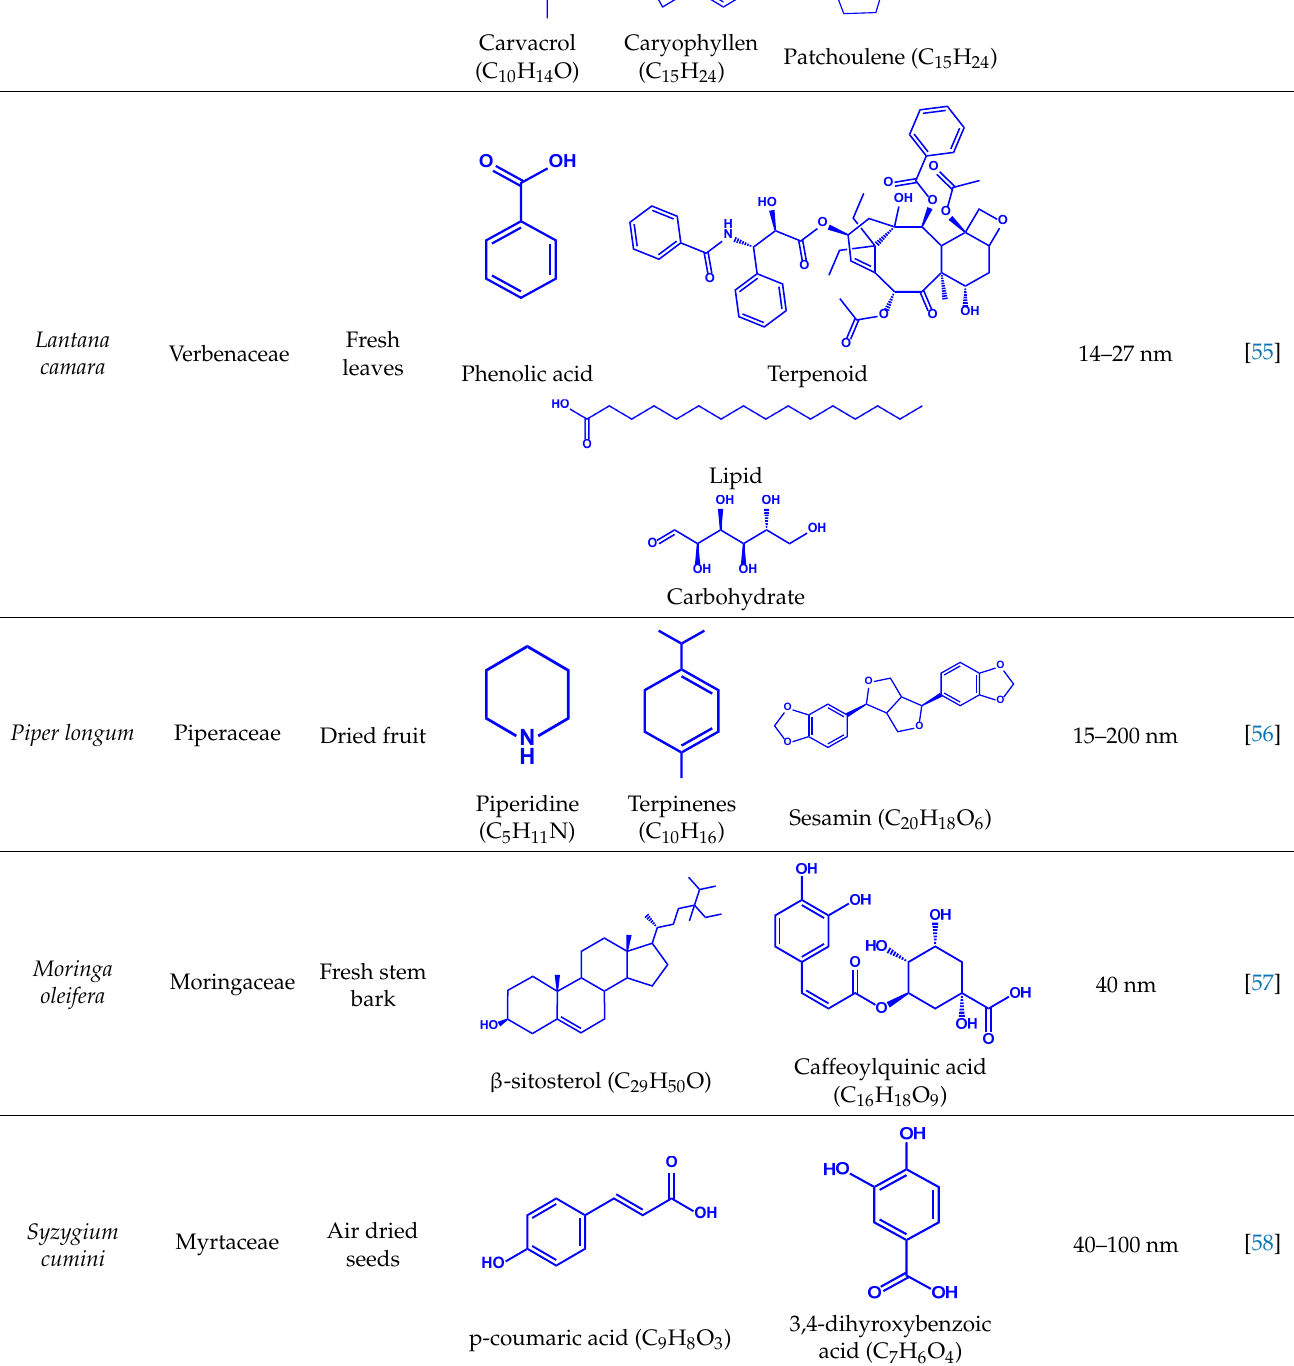
Metabolites and Their Structures